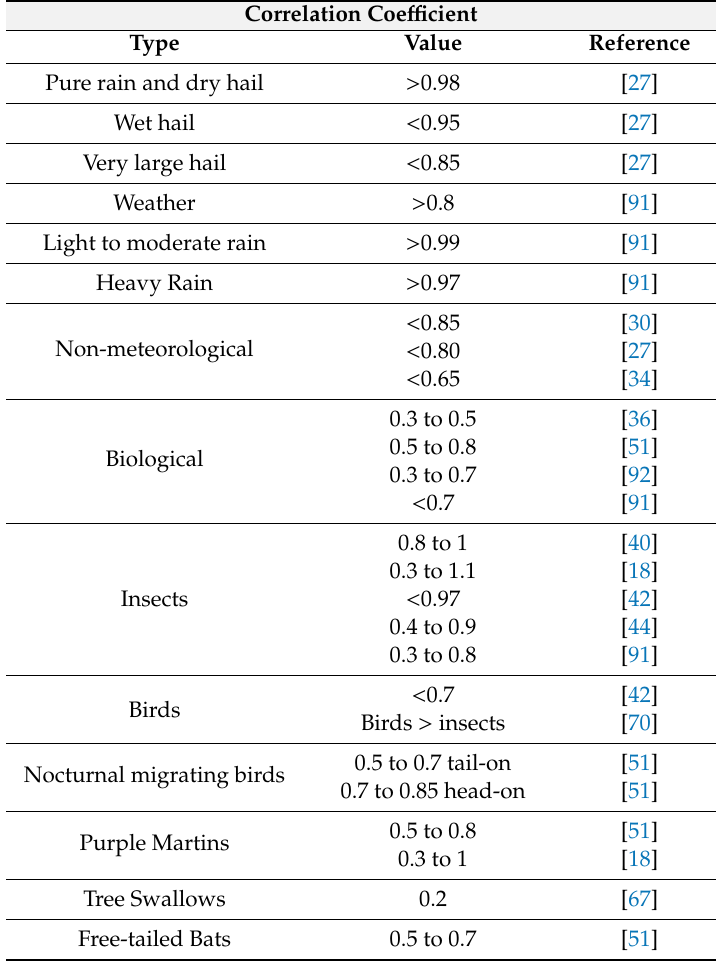
Table A3. Examples of correlation coe ffi cient values for di ff erent types of scatterers.